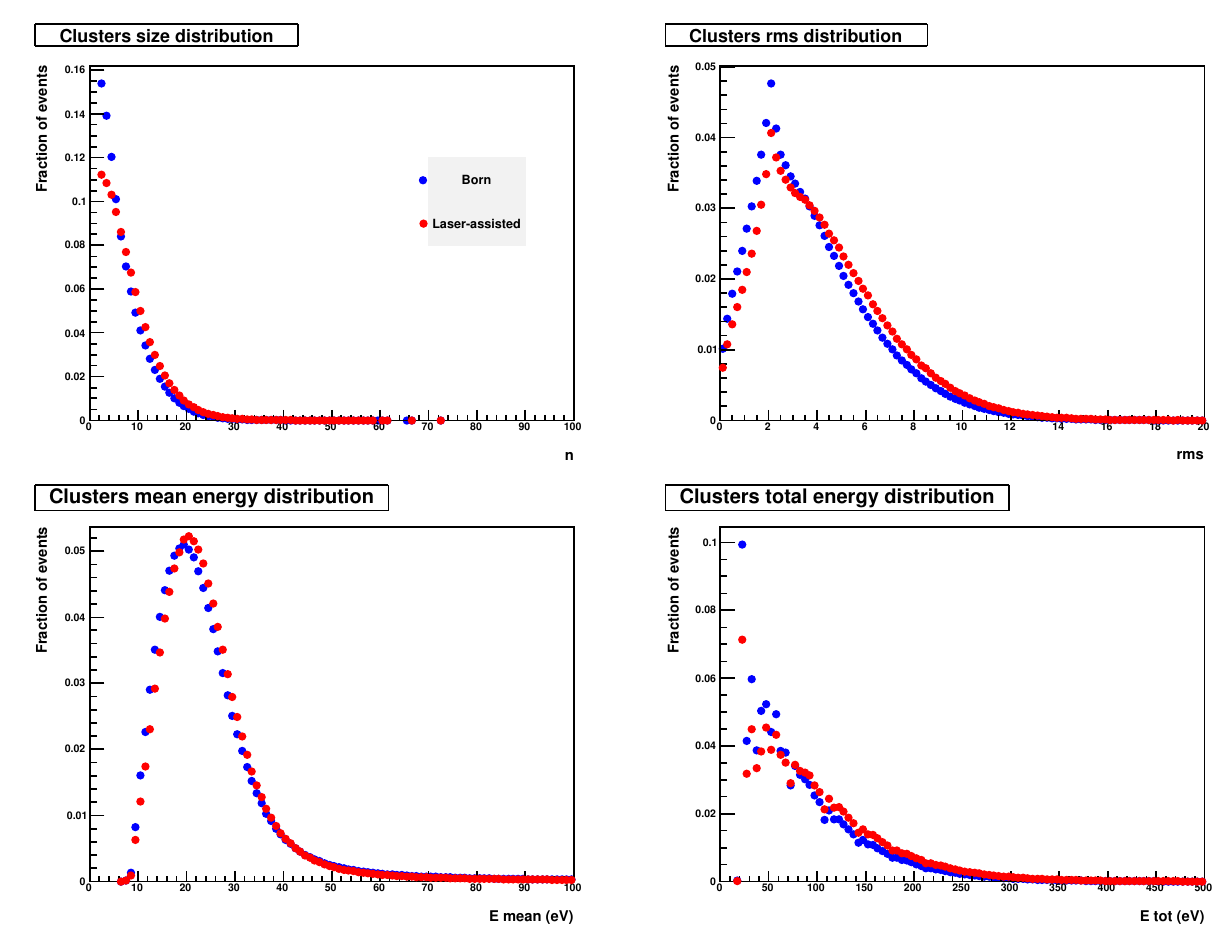
Figure 3. Simulated distributions of physical quantities describing the nanometric clusters of ionization for a 1 MeV irradiation of a micrometric volume (“cell nucleus”); • Born ionization process; • “laser-assisted” ionization